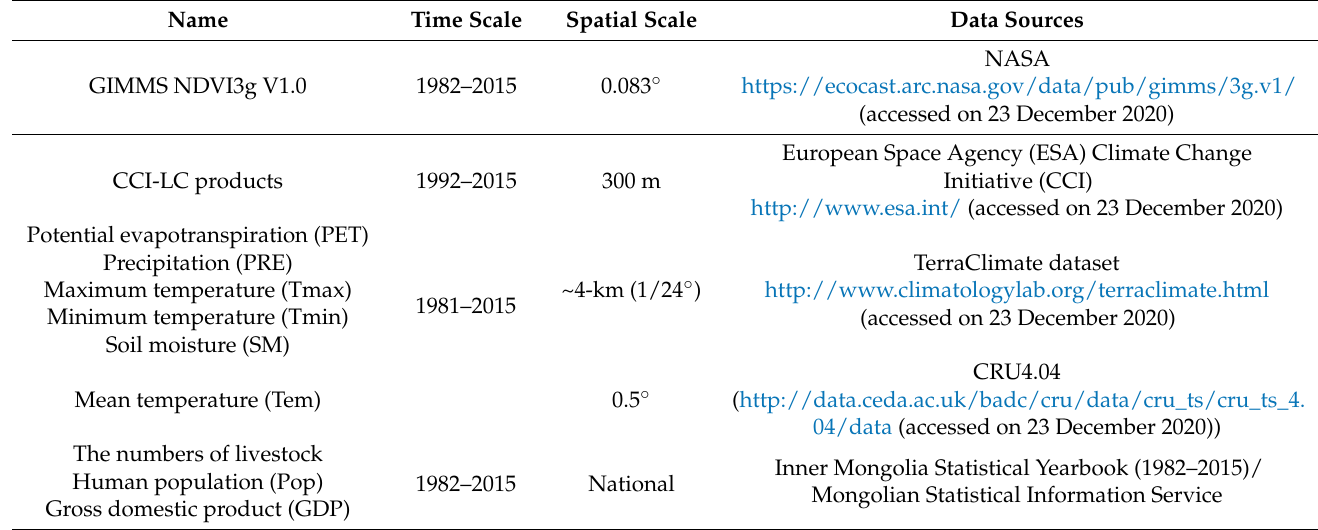
Table 1. List of data sources used in this